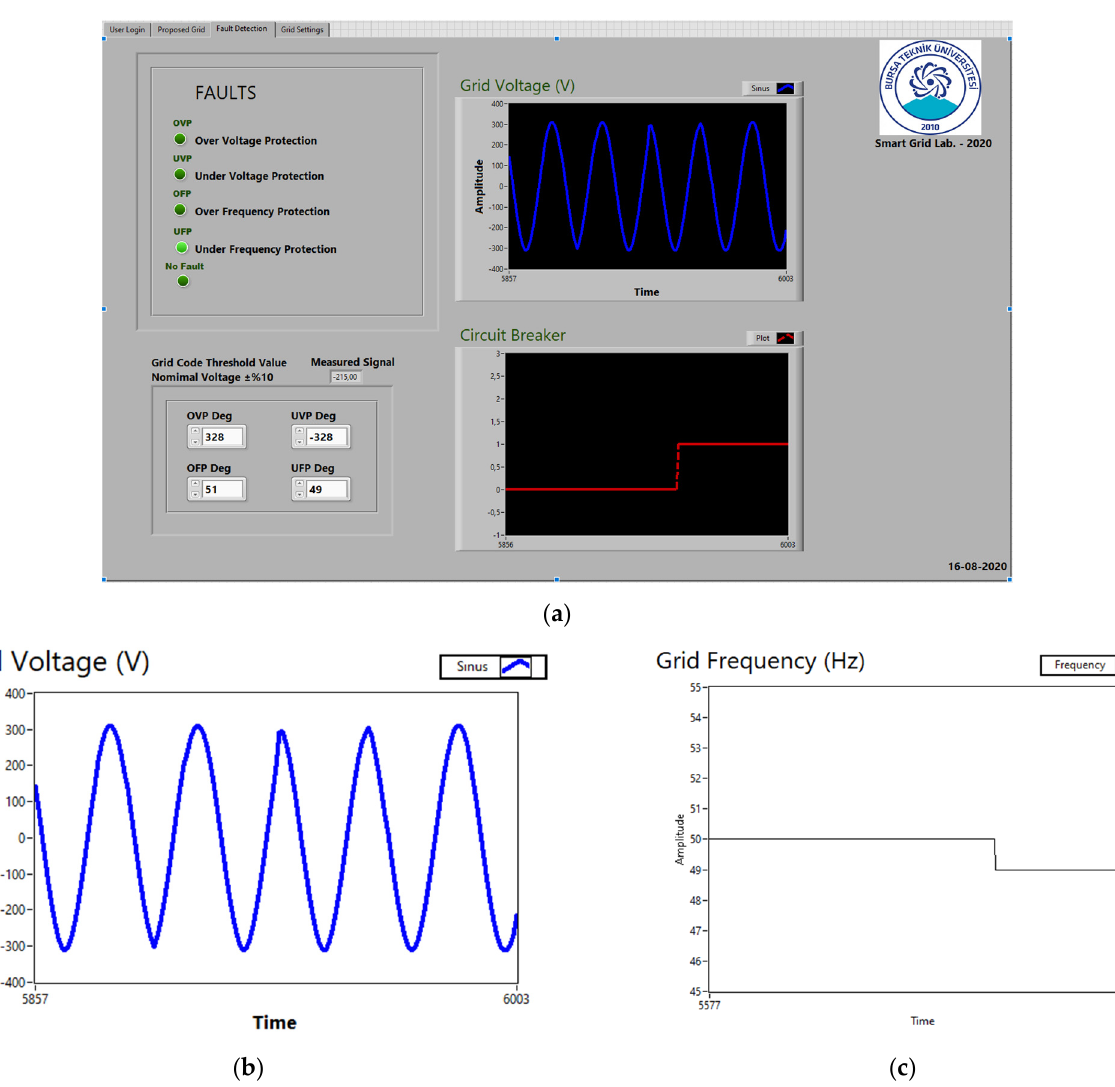
Figure 8. ( a ) UFP condition in DGPS and status of CB; ( b ) grid voltage; ( c ) grid frequency.